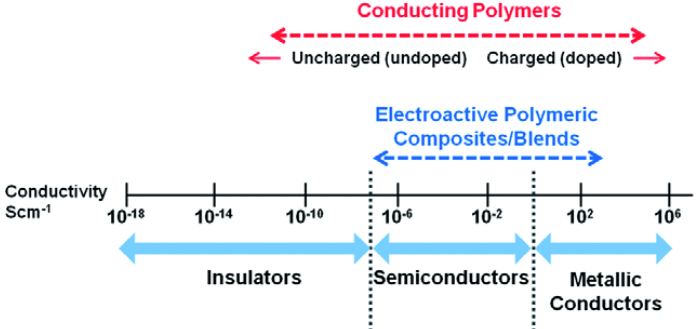
Figure 3. Conductivity range of polymers and conductive polymeric composites [203]. Reprinted with permission from Reference [203]. Copyright 2019 Royal Society of Chemistry.